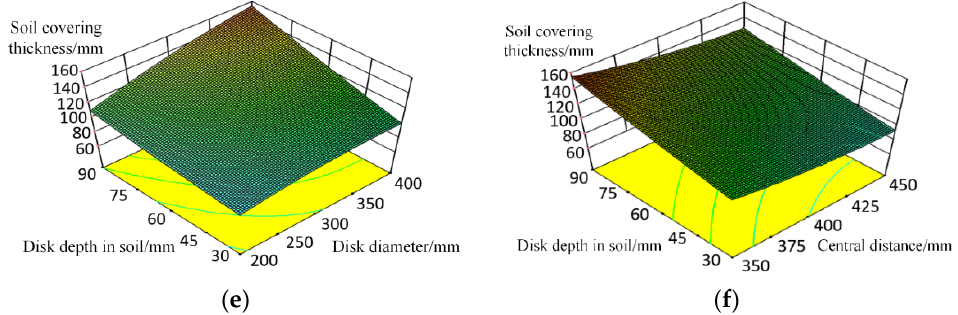
Figure 11. The analysis results of response surface between ( a ) dip angle and disk diameter, ( b ) central distance and disk diameter, ( c ) central distance and dip angle, ( d ) disk depth in soil and dip angle, ( e ) disk depth in soil and disk diameter, and ( f ) disk depth in soil and central distance.